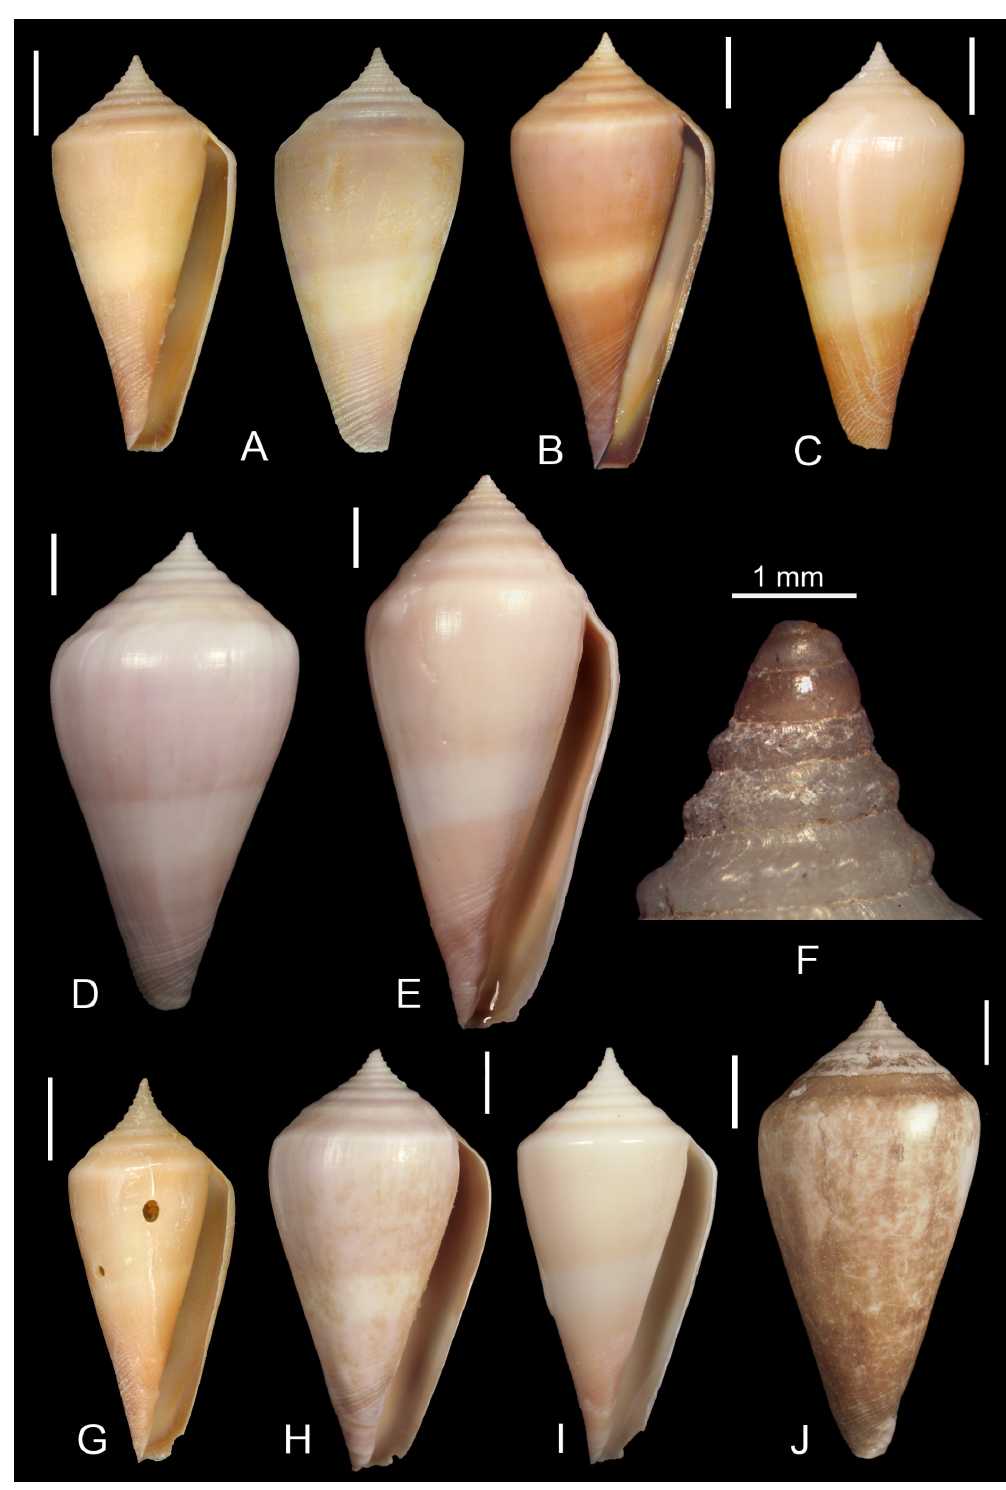
Fig. 15. Profundiconus neocaledonicus sp. nov. A . Holotype, 45.9 × 21.7 mm. B . Paratype 1, 61.3 × 28.1 mm. C . Paratype 2, 52.6 × 24.7 mm. D . Paratype 4, 71.8 × 37.0 mm. E . Paratype 5, 92.0 × 42.0 mm. F . Paratype 1, enlargement of the spire. G . Paratype 3, 46.7 × 20.4 mm. H . Paratype 6, 40.0 × 16.8 mm. I . Paratype 7, 54.5 × 25.4 mm. J . Paratype 8, 67.3 × 33.0 mm. Scale bars = 1 mm unless otherwise